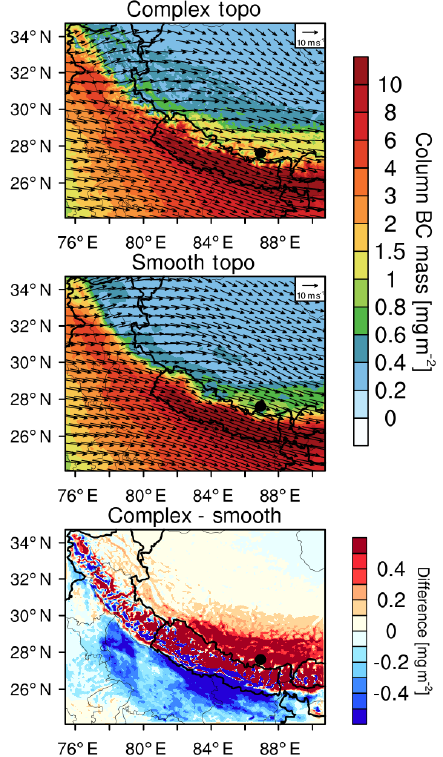
Figure 5. Spatial distributions of column-integrated BC mass and the horizontal wind field at 500hPa from the simulations with the complex and smooth topographies (complex topo and smooth topo) averaged for 1–20 April 2016. The difference between the two is also shown.